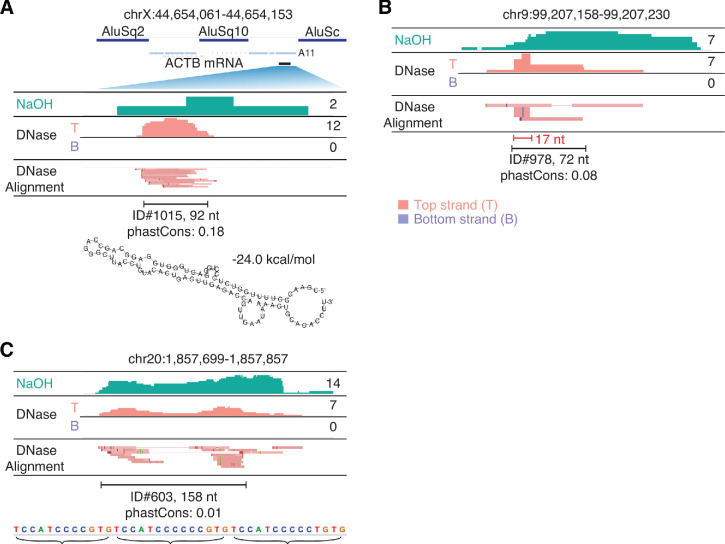
IGV screenshots showing peaks mapping to unannotated genomic loci.The hg19 genomic coordinates of the called peak are indicated at the top, and IGV alignments labeled as in Figure 9 are shown below. Peaks are delineated by a bracketed black line, with peak ID number, length, and phastCons scores for 46 vertebrates indicated below. (A) A peak corresponding to a segment of a retrotransposed mRNA with a short poly(A) tail (A11). The retrotransposed mRNA sequence (blue line) is flanked by two Alu elements and has an internal Alu element insertion. The segment of the mRNA sequence corresponding to the peak (black bar) is expanded for the IGV alignments. The most stable predicted secondary structure and its MFE (ΔG) computed by RNAfold are shown below. (B) A peak containing a short (17 nt) RNA with discrete 5' and 3' ends (bracketed red line) (C) A peak containing reads with heterogenous 5' and 3' ends containing tandem repeats of the sequence indicated below.